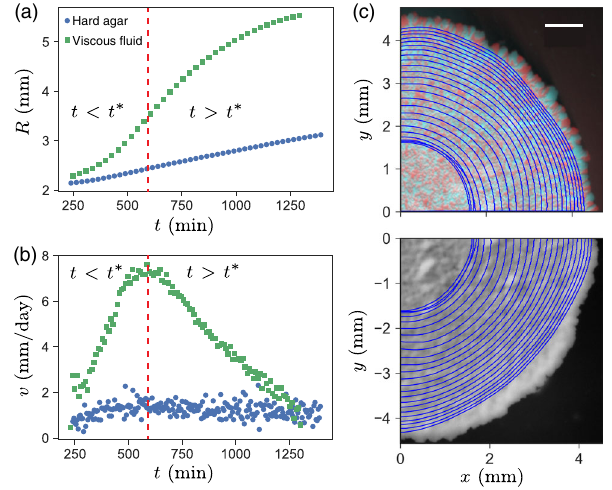
FIG. 2. (a) Azimuthally averaged yeast colony radius R ð t Þ during the first 24 h of growth on hard agar (blue circles) and on a liquid substrate with viscosity η ¼ 600 (cid:2) 90 Pa s (green squares). (b) The corresponding colony front velocity is extracted from R ð t Þ . The colony exhibits two growth regimes on the liquid substrate: a superlinear regime for t < t (cid:3) and a slowly decaying phase for t > t (cid:3) . We find that the colony front velocity approaches v ð t Þ ¼ 0 . 5 (cid:2) 0 . 05 mm = day at long times ( t ≫ t (cid:3) ) which is less than the velocity of yeast colonies growing on 2% hard agar plates. (c) Consecutive front spatial positions at equal 40-min intervals during the first 24 h of growth on liquid substrate with the same viscosity as (a) and (b), overlayed on top of a fluorescent (top) and a bright-field (bottom) image of the colony. Note that genetic demixing begins at the edge of the colony after the front slows down. The scale bar corresponds to 1